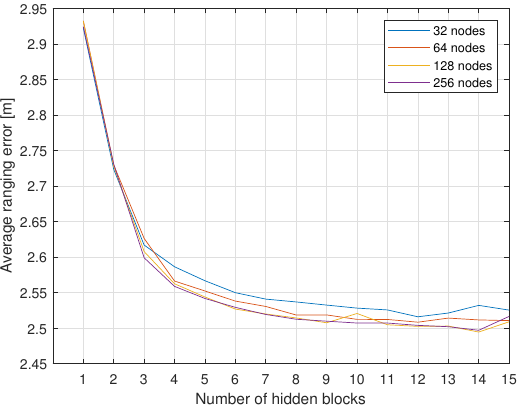
Figure 11. Average ranging error according to the structure of the neural